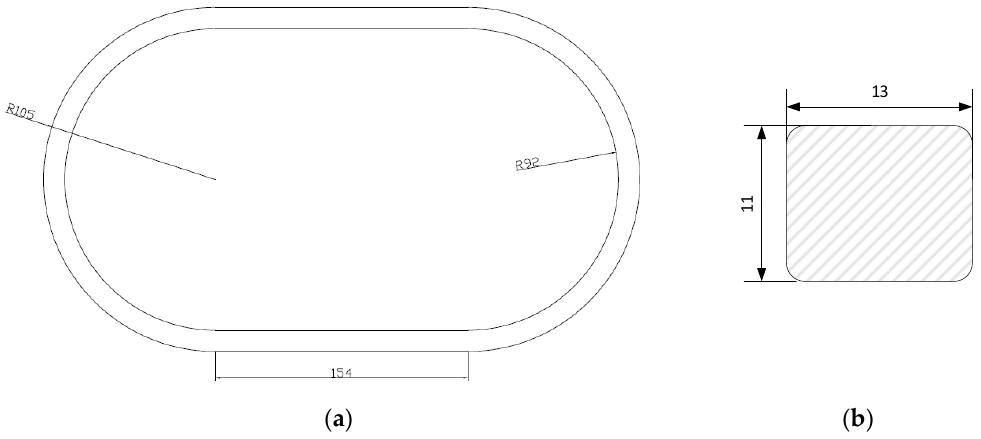
Figure 3. Current transformer ( a ) dimension and ( b ) core cross-section (Lengths in millimeters).